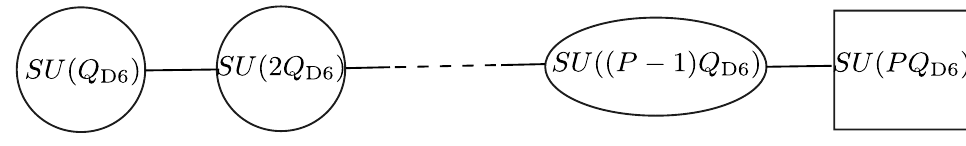
Figure 2 . Quiver describing the 4d N = 2 SCFT dual to the background